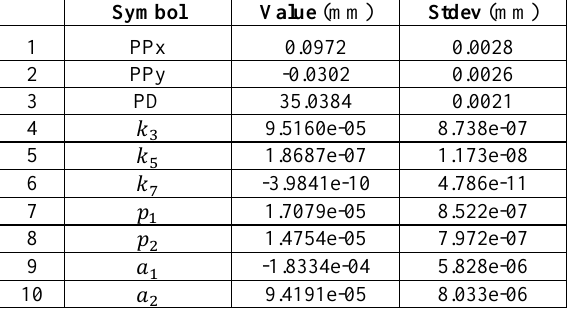
Table 2. Values of lens distortion parameters fitted by VMS.